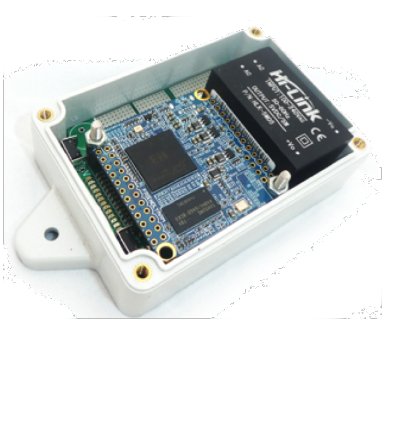
Figure 2. oZm hardware elements. ( Left ): full system including plastic enclosure. ( Right ): components side by side with ARM nanopi Air, analog front end (AFE), and Li-Po